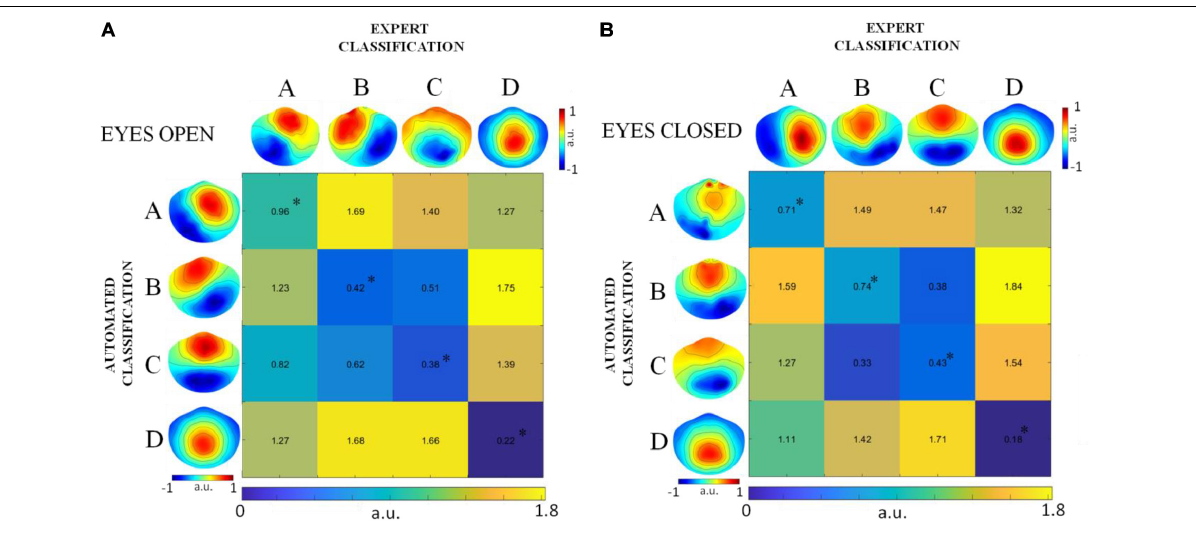
FIGURE 2 | GD values obtained for paired global microstate templates in the eyes open condition (A) and in the eyes closed condition (B) . Diagonal values correspond to the GD between global microstate templates of the same type obtained from DNEEG1-EO and DNEEG2-EO (A) and from DNEEG1-EC and DNEEG2-EC (B) . The asterisk indicates GD values for which p <